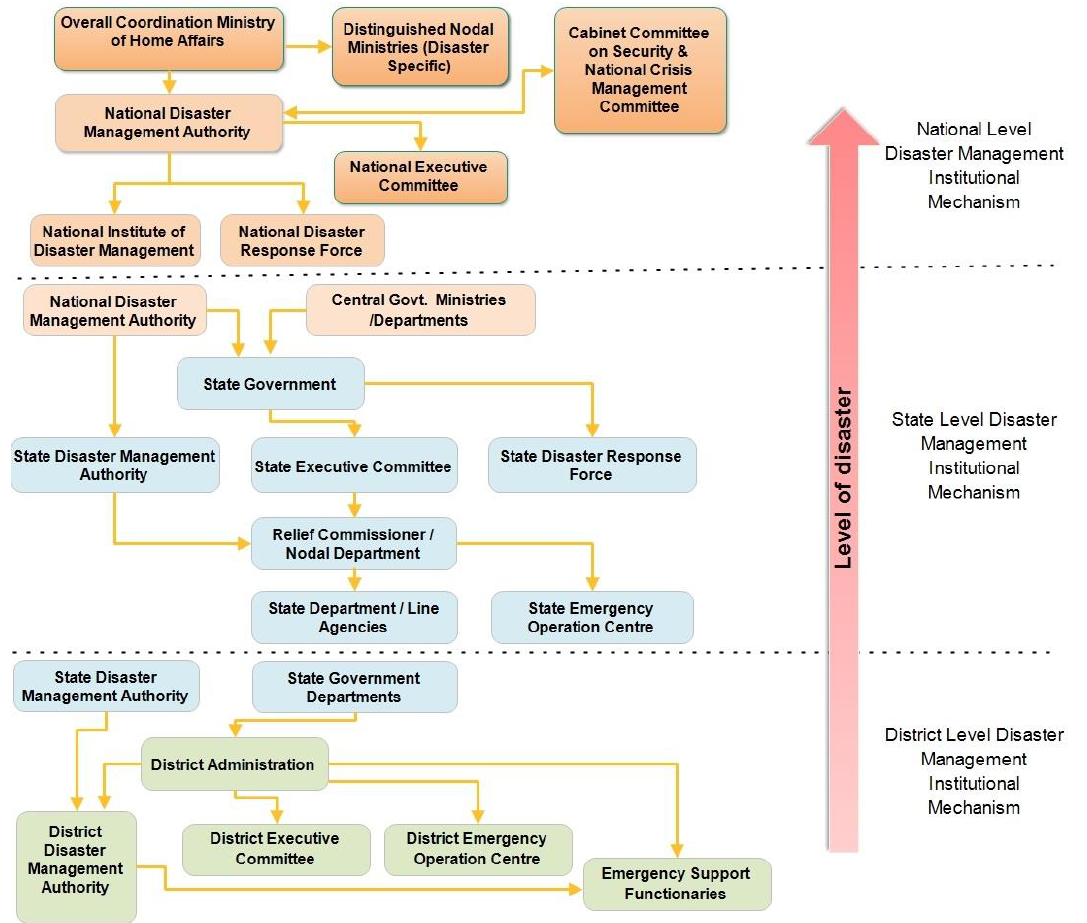
Figure 4. Organisational structure and responsible institutions for DRM in India. Partially sourced from NPDM, India [74] (accessed on 19 May 2021).